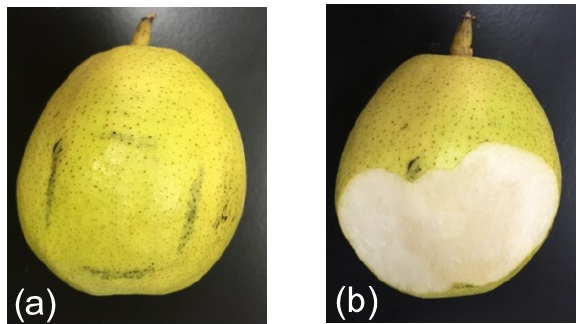
Figure 1. The bruised area of a Korla pear after the pear was left in the laboratory at room temperature for 24 h (to allow the bruise to develop). ( a ) The bruised area (in black frame) was similar to normal area around it; ( b ) When the peel of bruised area was cut off, there were differences between normal and bruised area in color.